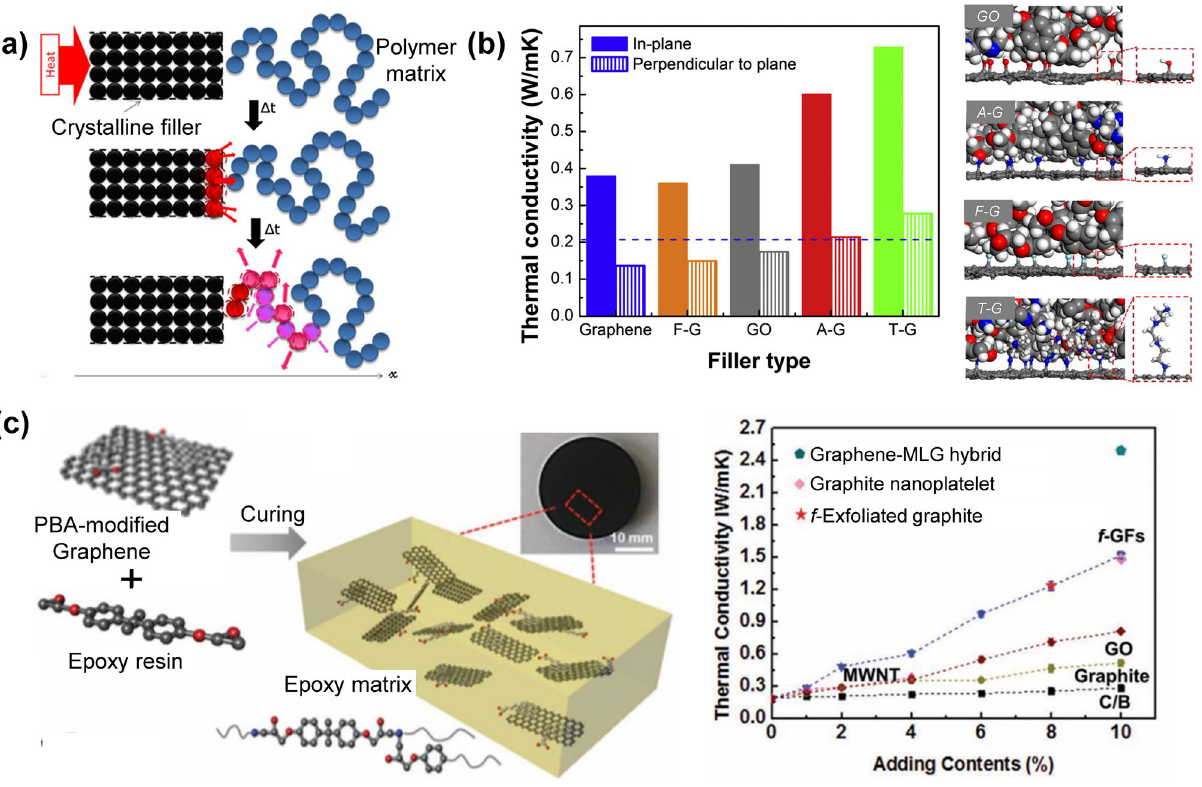
Fig. 4 a Schematic illustrating the thermal conduction mechanism at the interface between the crystal filler and the polymer [37]. b, c Enhance‑ ment of thermal conductivity of graphene/polymer composites by graphene surface modification [23,